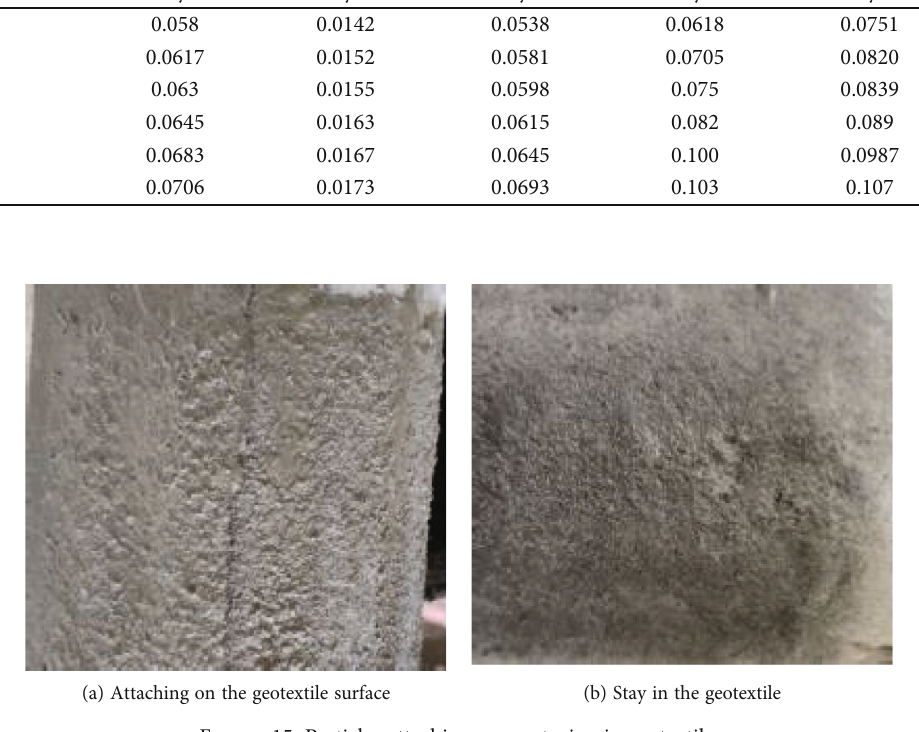
Figure 15: Particles attaching on or staying in